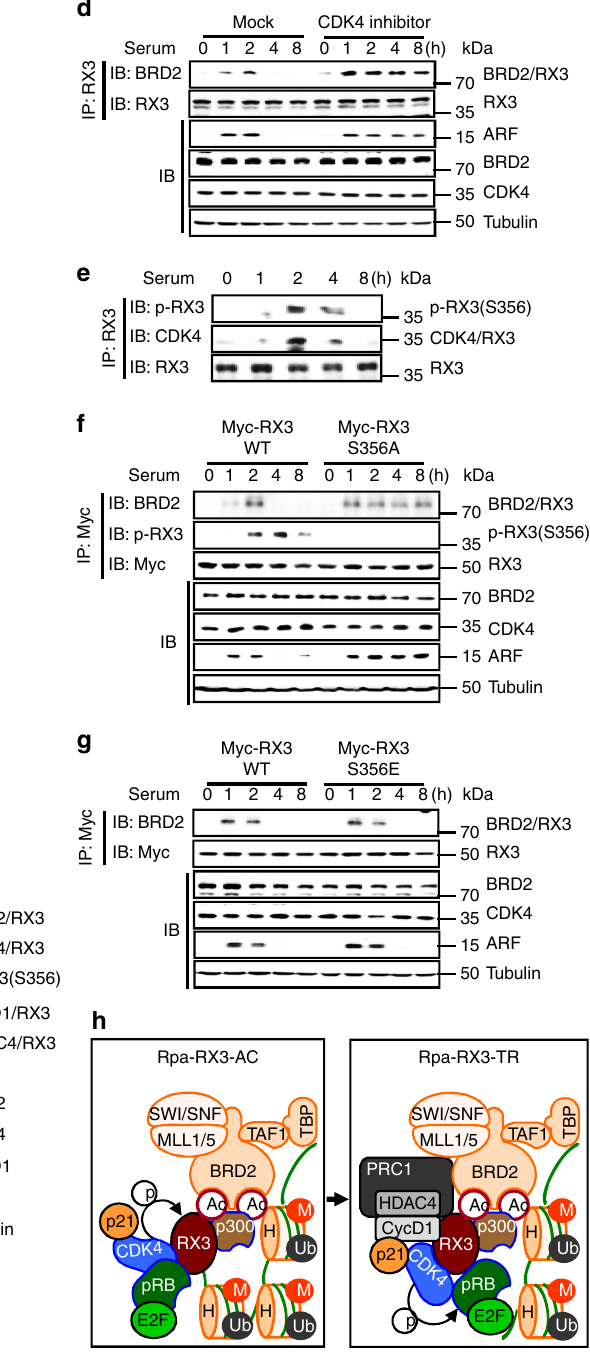
Activation of CDK4 depends upon CDK-activating kinase (CAK) activity 26 . JNK was identi fi ed as one of the CAKs that phosphorylates CDK4 at T172 27 . We found that JNK phosphor- ylates CDK4 (at T172) 2 h after serum stimulation (Fig. 5c). Pharmacological inhibition of JNK activity markedly reduced RUNX3 phosphorylation at Ser-356 and maintained Rpa-RX3- AC for up to 8 h (Fig. 5d). Similarly, siRNA-mediated knockdown of JNK also decreased RUNX3 phosphorylation at Ser-356 and maintained Rpa-RX3-AC (Fig. 5e). Exogenously expressed Flag- CDK4-WT phosphorylated Myc-RUNX3 2 – 4 h after serum stimulation. However, Flag-CDK4-T172A (lacking the residue phosphorylated by JNK) failed to phosphorylate RUNX3 at